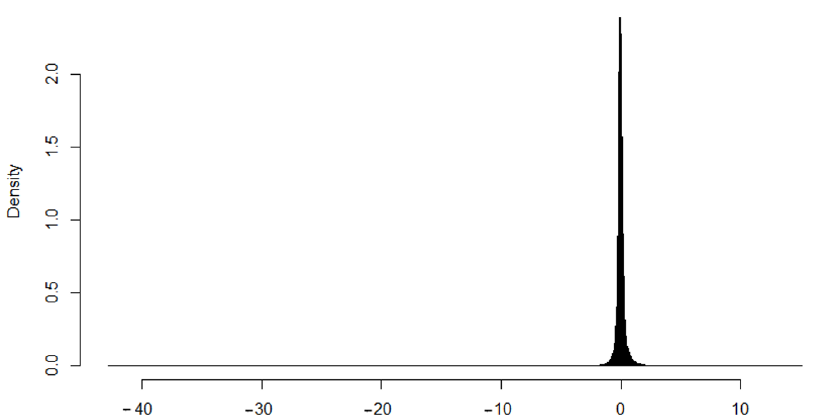
Figure 4. Histogram of the discrepancies model (error model) of the Allo zone (DEM05-DEM02).